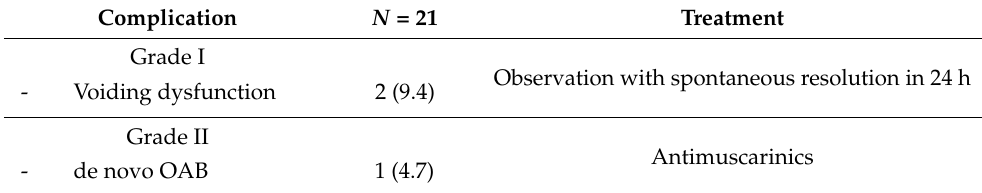
Table 3. Clavien–Dindo classification of